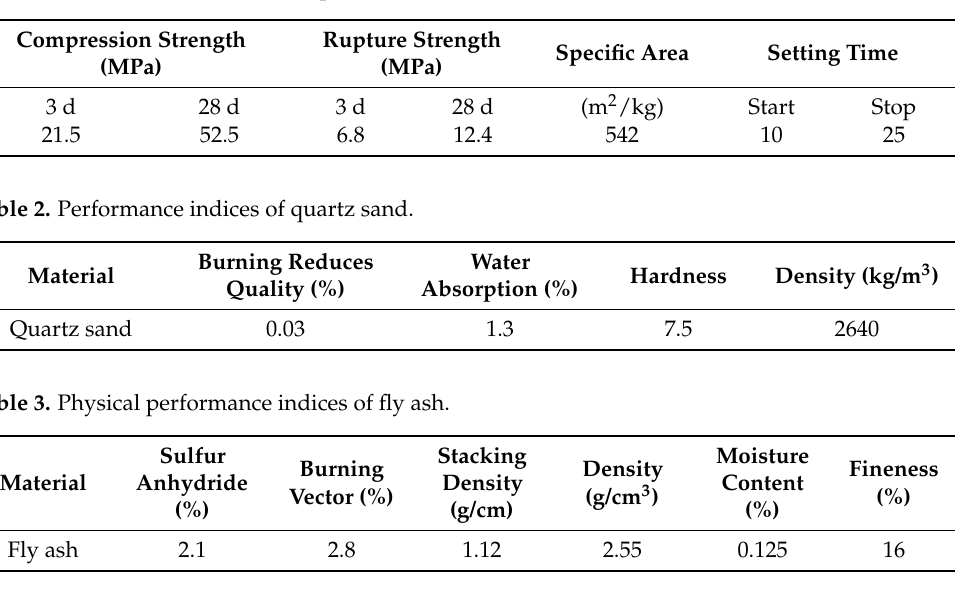
Table 1. Performance indices of sulphoaluminate cement.